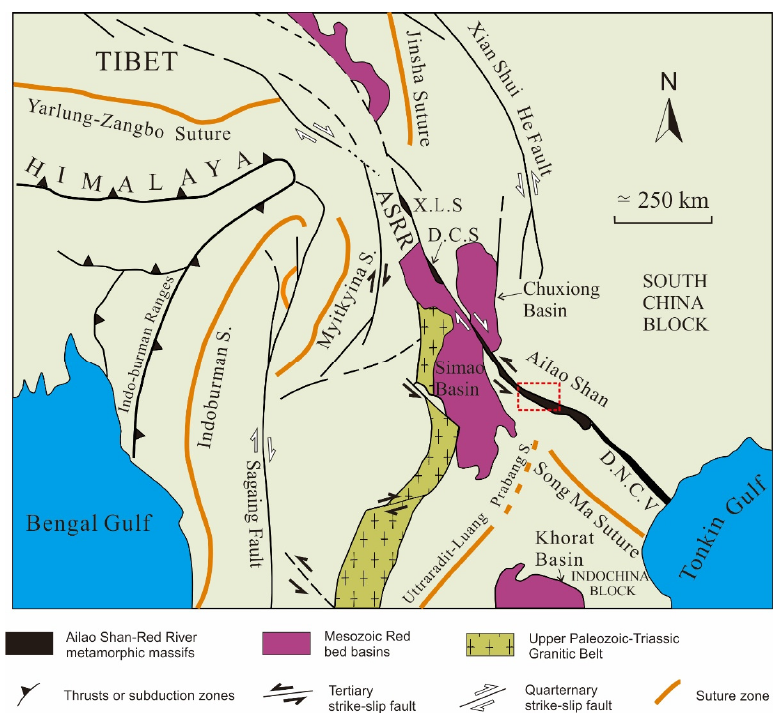
Figure 1. Simplified tectonic sketch of SE Asia showing the ASRR metamorphic terranes (modified after Leloup et al. [7]) with marked study area. The ASRR strike-slip metamorphic zone is comprised of four metamorphic terranes: Ailao Shan, Xuelong Shan (XLS), Diancang Shan (DCS), and Day Nui Con Voi (DNCV).